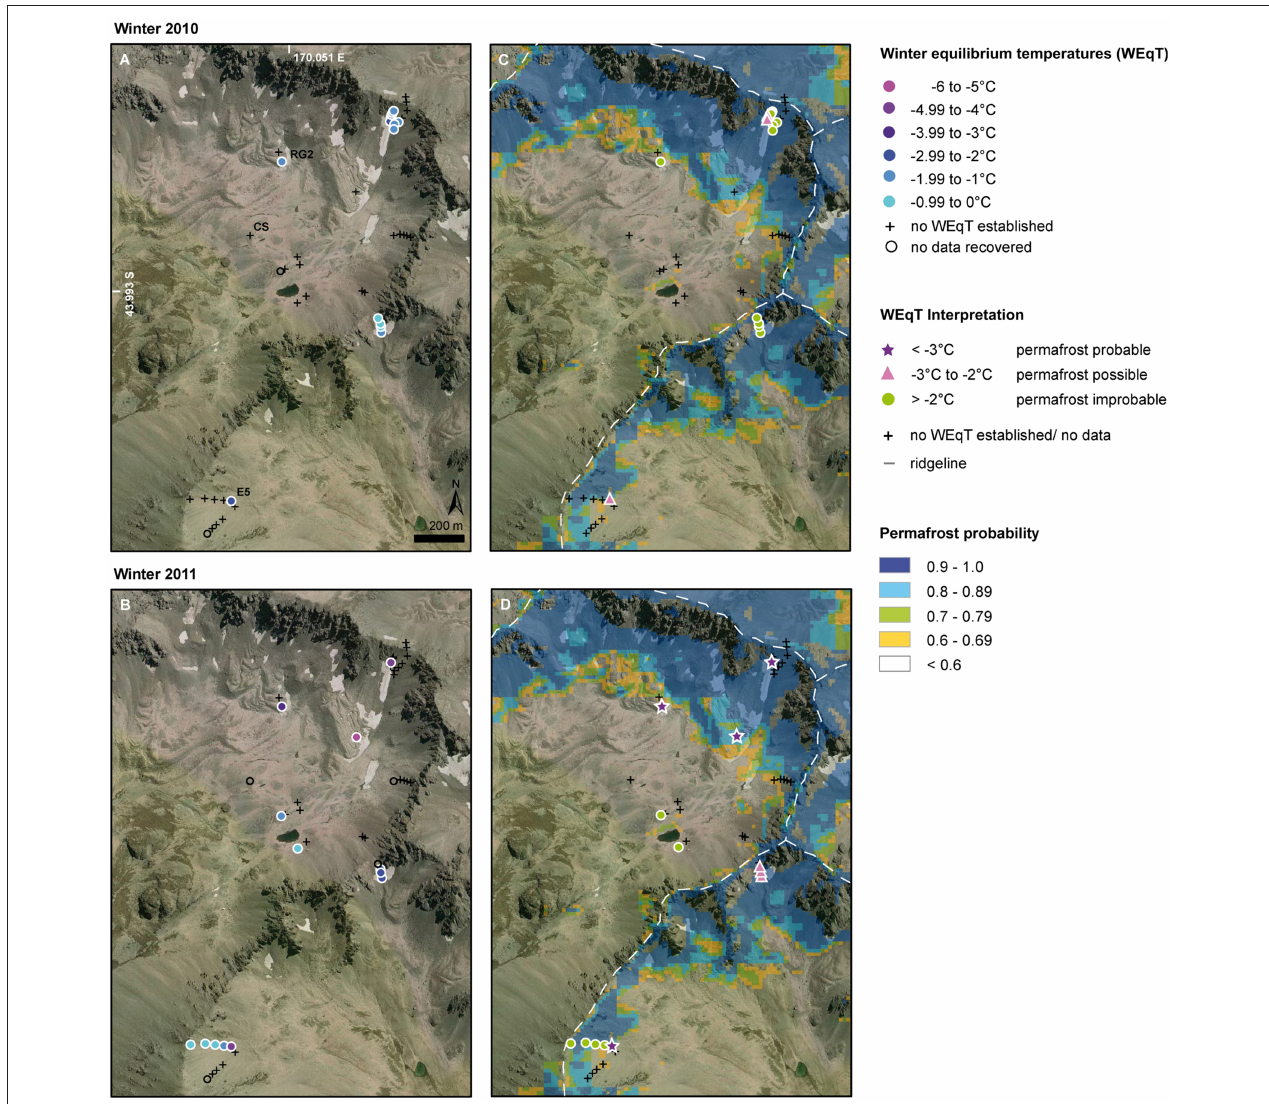
FIGURE 7 | Winter equilibrium temperature (WEqT; A,B) and inferred permafrost probability (C,D) at the ground surface temperature monitoring sites in the Irishman Stream area for winter 2010 and 2011. In panel (C,D) , rock faces are masked by removing areas with a gradient ≥ 40 ◦ from the modeled permafrost extent. The modeled permafrost extent matches the WEqT-indicated permafrost sites well, suggesting a reasonable model output. Basemap: Orthophotograph 2006 (Terralink,